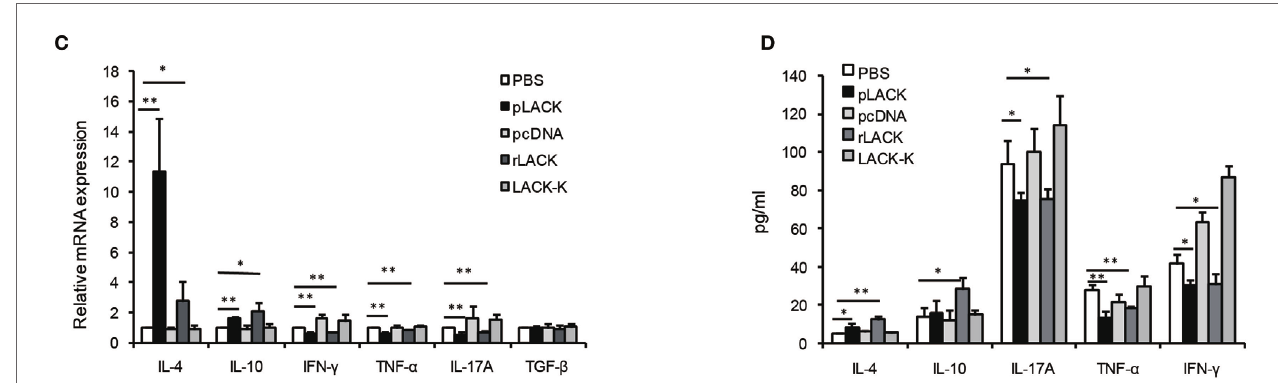
FigUre 4 | The effect of LACK 156–173 epitope-matured dendritic cells (DCs) in collagen antibody-induced arthritis (CAIA) mice on T cell polarization and function in vitro . LACK 156–173 epitope-matured CD11c + DCs were prepared from the spleens of CAIA mice, as described in Section “Analysis of the Phenotypes of DCs and the In Vitro Polarization of T Cells From CAIA Mice.” CD11c + DCs were co-cultured for 72 h with T cells, isolated via nylon wool fiber in a syringe, from the spleens of BALB/c mice that had been i.p. injected with 100 µg OVA 323–339 7 days before isolation. (a,c) Cytokine mRNA expression. (B) The numbers of interleukin (IL)-4 + cells, IFN- γ + cells, IL-17A + cells, and Foxp3 + cells were measured by flow cytometry. (D) The concentrations of the cytokines in the culture supernatants. One representative of three independent experiments is shown. Results are expressed as mean ± SEM. * p < 0.05, ** p <